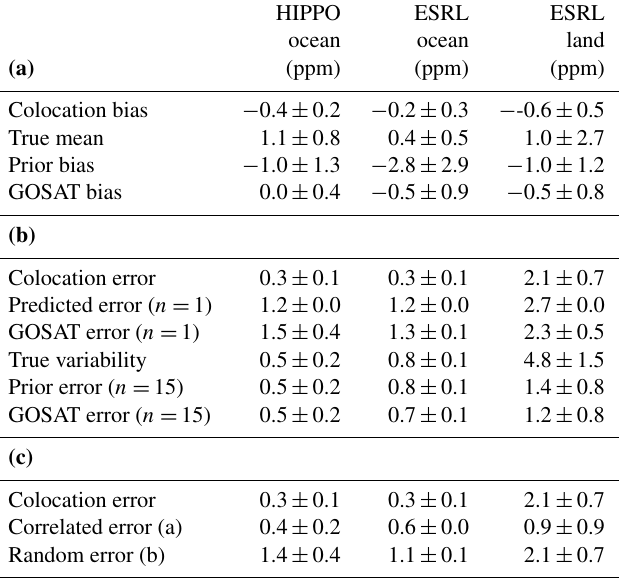
Table 8. (a) Bias terms for LMT – U . Compare to Table 4. (b) Standard deviations for LMT – U . Compare to Table 5. The predicted errors in the table use the errors given at the end of Sect. 5.1.5. (c) Error fits for LMT – U . Compare to Table